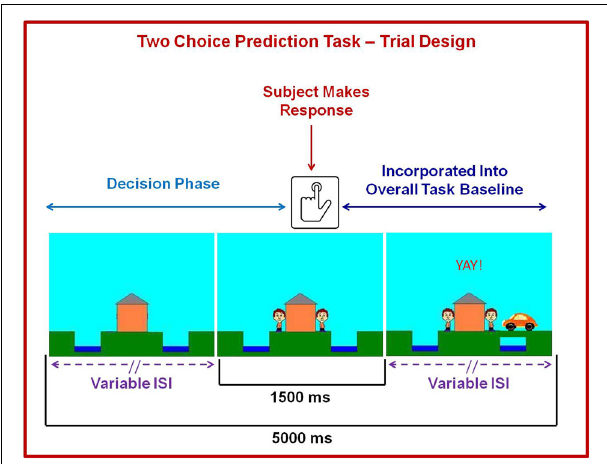
FIGURE 2 | Illustration of two choice prediction task. For each trial, a house was shown in the center with two people: one on the left and one on the right of the house. Subjects pressed a button to predict whether a car would come by on the left or right side to pick up the person. After the subject made a decision, the car was presented on the left or right side of the screen. If the selected response matched the side where the car was presented, the person on the selected side met up with the car. Although each trial lasted 5000ms and subjects were allowed to respond with a button press during a fixed 1500ms period at the point when they saw the two people on the screen, the length of the beginning and ends of each trial were designed to have variable interstimulus intervals (lSI). Brain activation consisting of time from trial onset to the button press was included in fMRI analysis as a decision regressor of interest, wherein brain activation during the remainder of the trial was incorporated into the overall baseline